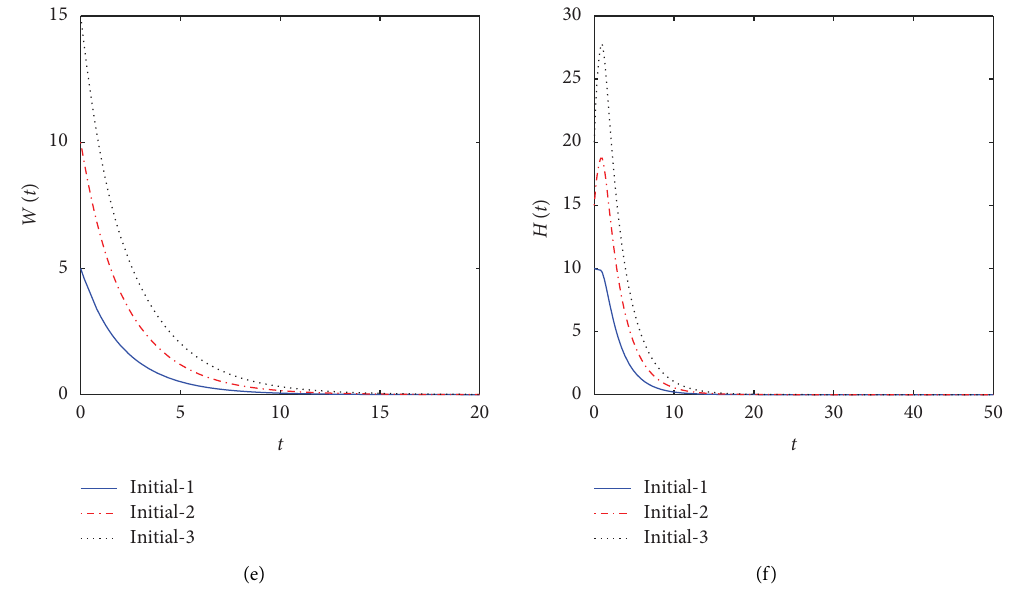
Figure 2: Te numerical simulations of model (64) for η � 0 . 006, υ � 0 . 01, ℘ � 0 . 3, and I � 0 . 0001 using three diferent initial conditions � ( 22 . 41 , 0 , 0 , 1000 , 0 , 0 ) is G.A.S. (a) Uninfected epithelial cells. (b) Infected epithelial cells. (c) sets. Uninfected equilibrium EP 0